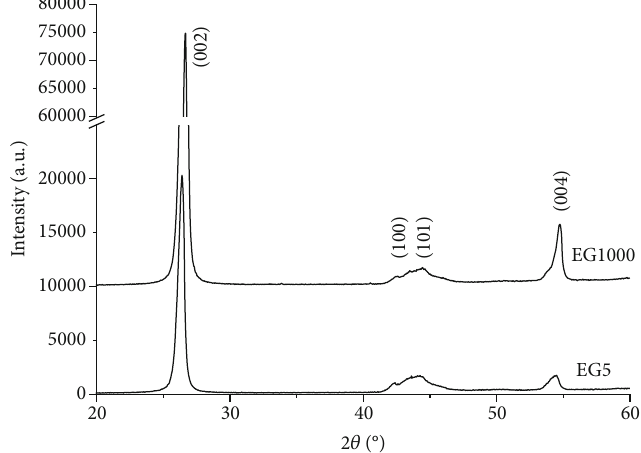
Figure 2: XRD spectra of graphites EG5 and EG1000.